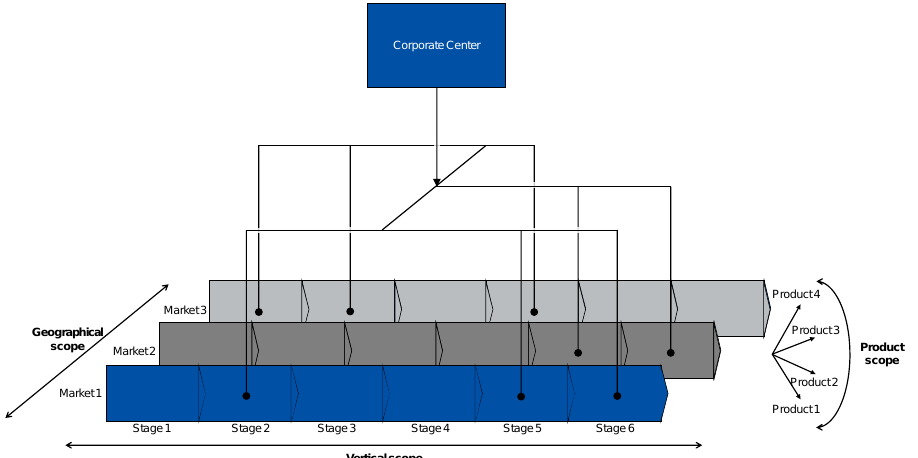
Figure 1. Organizational structure of a firm regarding the geographical, vertical, and product scope. Own illustration, based on [9] (pp. 348–351).